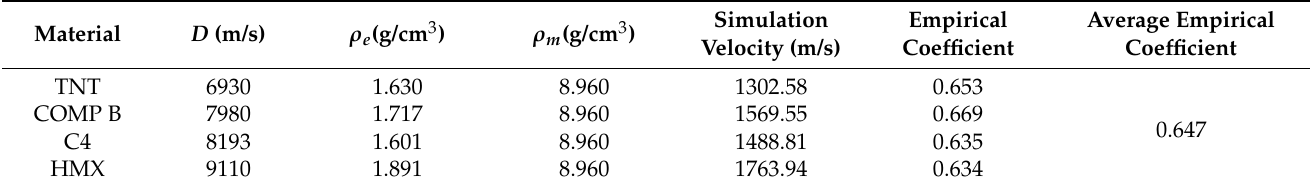
Table 6. Empirical coefficient of the head velocity of projectiles with different types of charge materials in